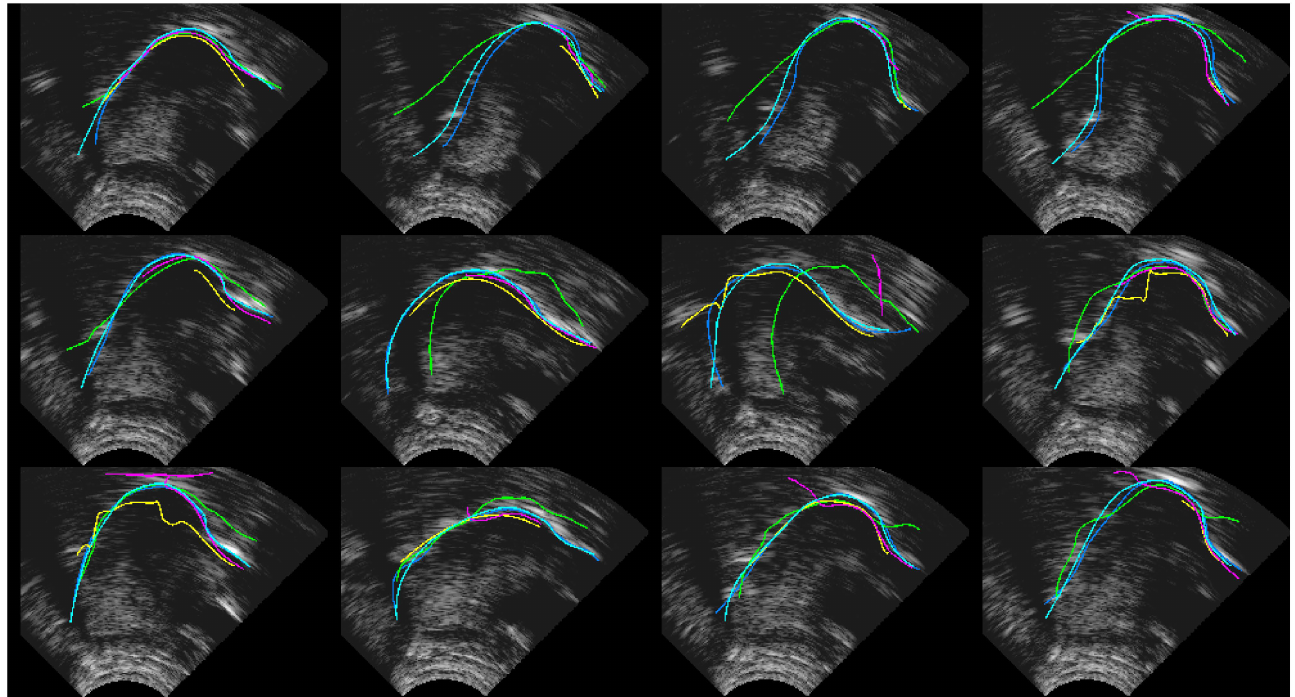
Figure 10. Speaker TaL17ms; blue—hand-label; green—SLURP; yellow—MTracker; pink—DeepEdge; cyan—DLC_ResNet50.